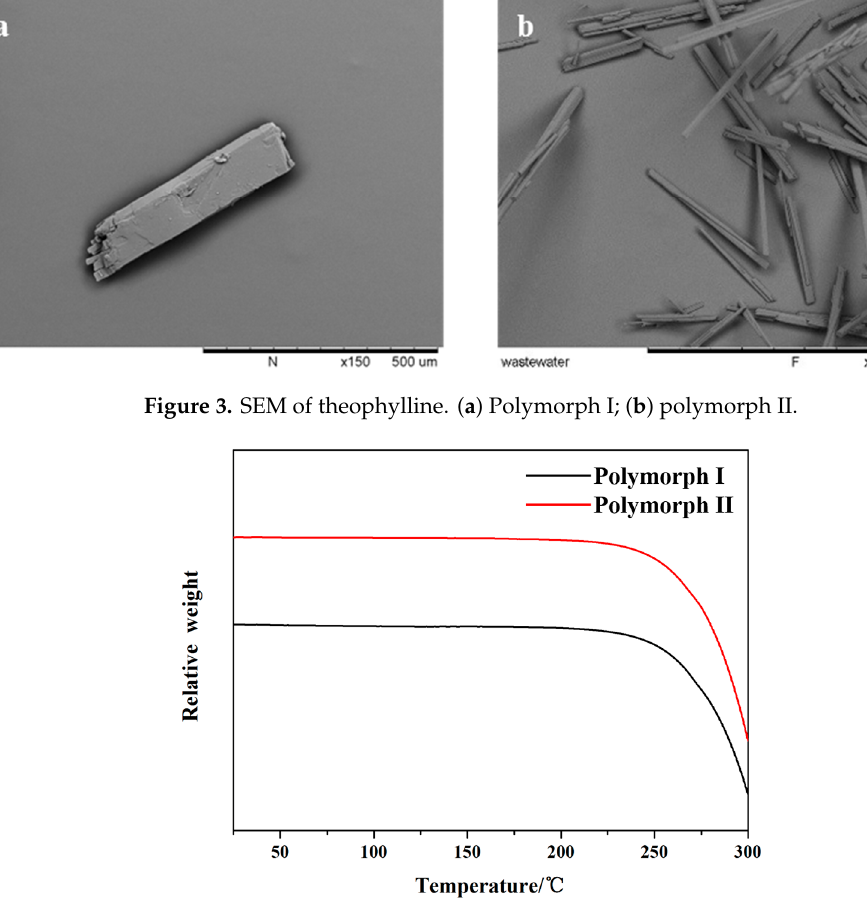
Figure 4. TGA graphs of polymorph I and polymorph II of theophylline.